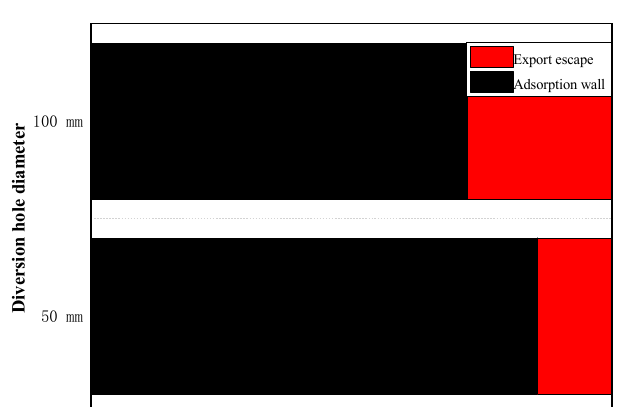
Figure 13. Bar graph of inclusion removal rate of different retaining wall opening diameters.